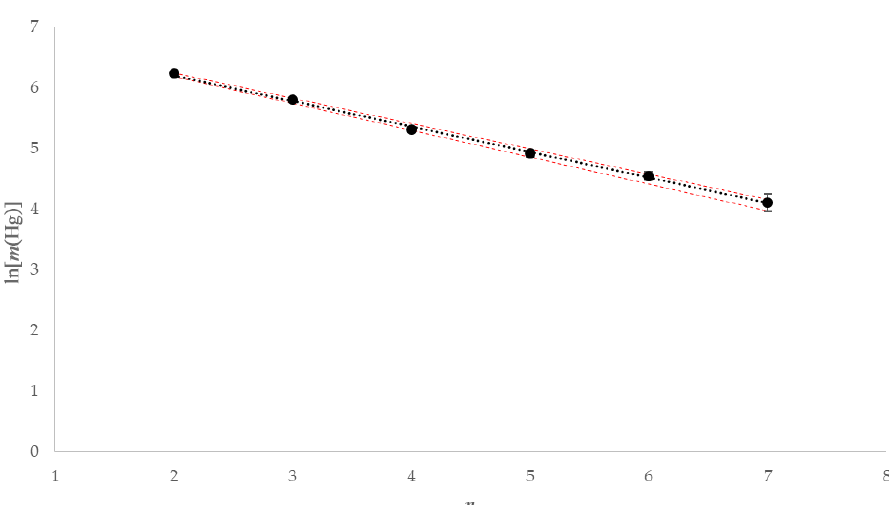
Figure 11. Example ln [ m( Hg ) ] against extraction number ( n ) and linear regression for KCl at 5 ◦ C (red error bars ± 1 u c [ k =